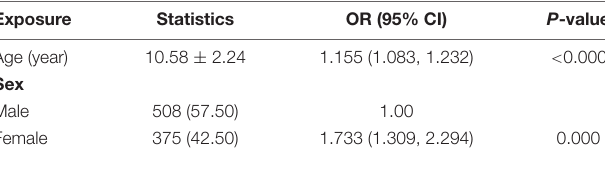
TABLE 2 | Clinical data comparison between patients with positive and negative HUTT response in the study group [mean ± SD, n (%)]. HUTT result HUTT negative HUTT positive